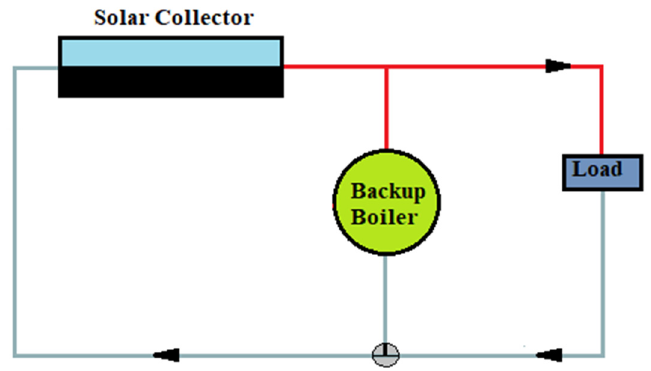
13 Figure 9. Heat exchanger-based steam generation system with backup in series connection. Adapted from Ref. [44], Copyright (1985), with permission from Elsevier. 4.3.2. Direct Steam Generation Systems A direct steam generating system excludes the use of a heat exchanger and can con-